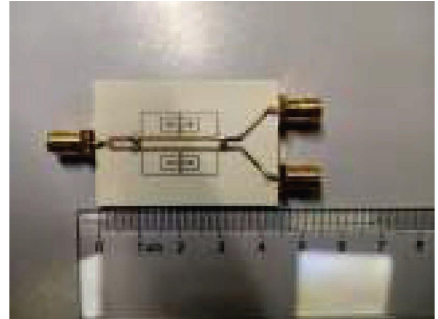
Figure 8: Photograph of the fabricated FPD.